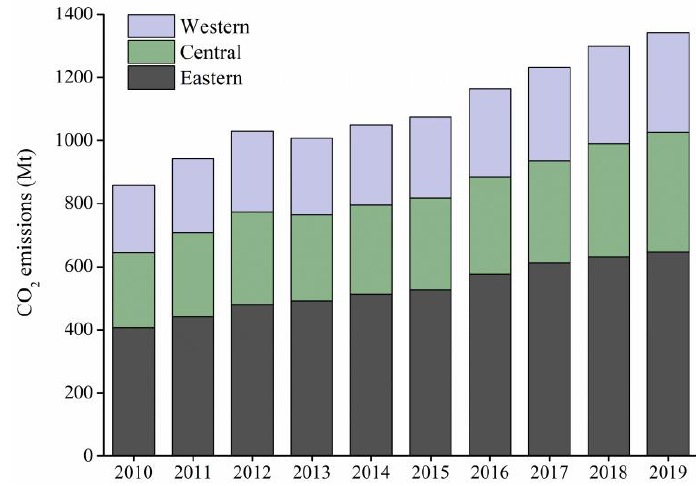
Figure 3. RCE of the three study regions in China during 2010 – 2019. Per capita RCE is used to describe the differences between urban and rural